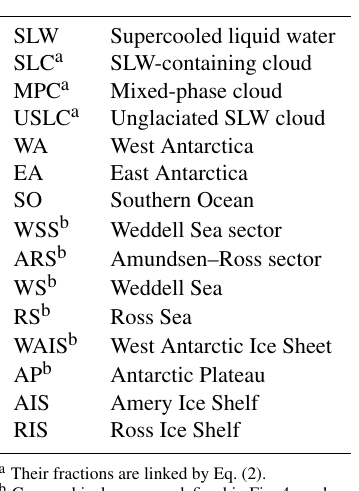
Table 1. Acronyms used in the text to designate some cloud phase or cloud types and some Antarctic places or